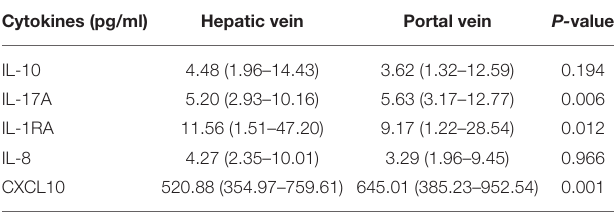
TABLE 1 | Baseline characteristic of the study population. TABLE 2 | The level of cytokines in the hepatic vein and portal